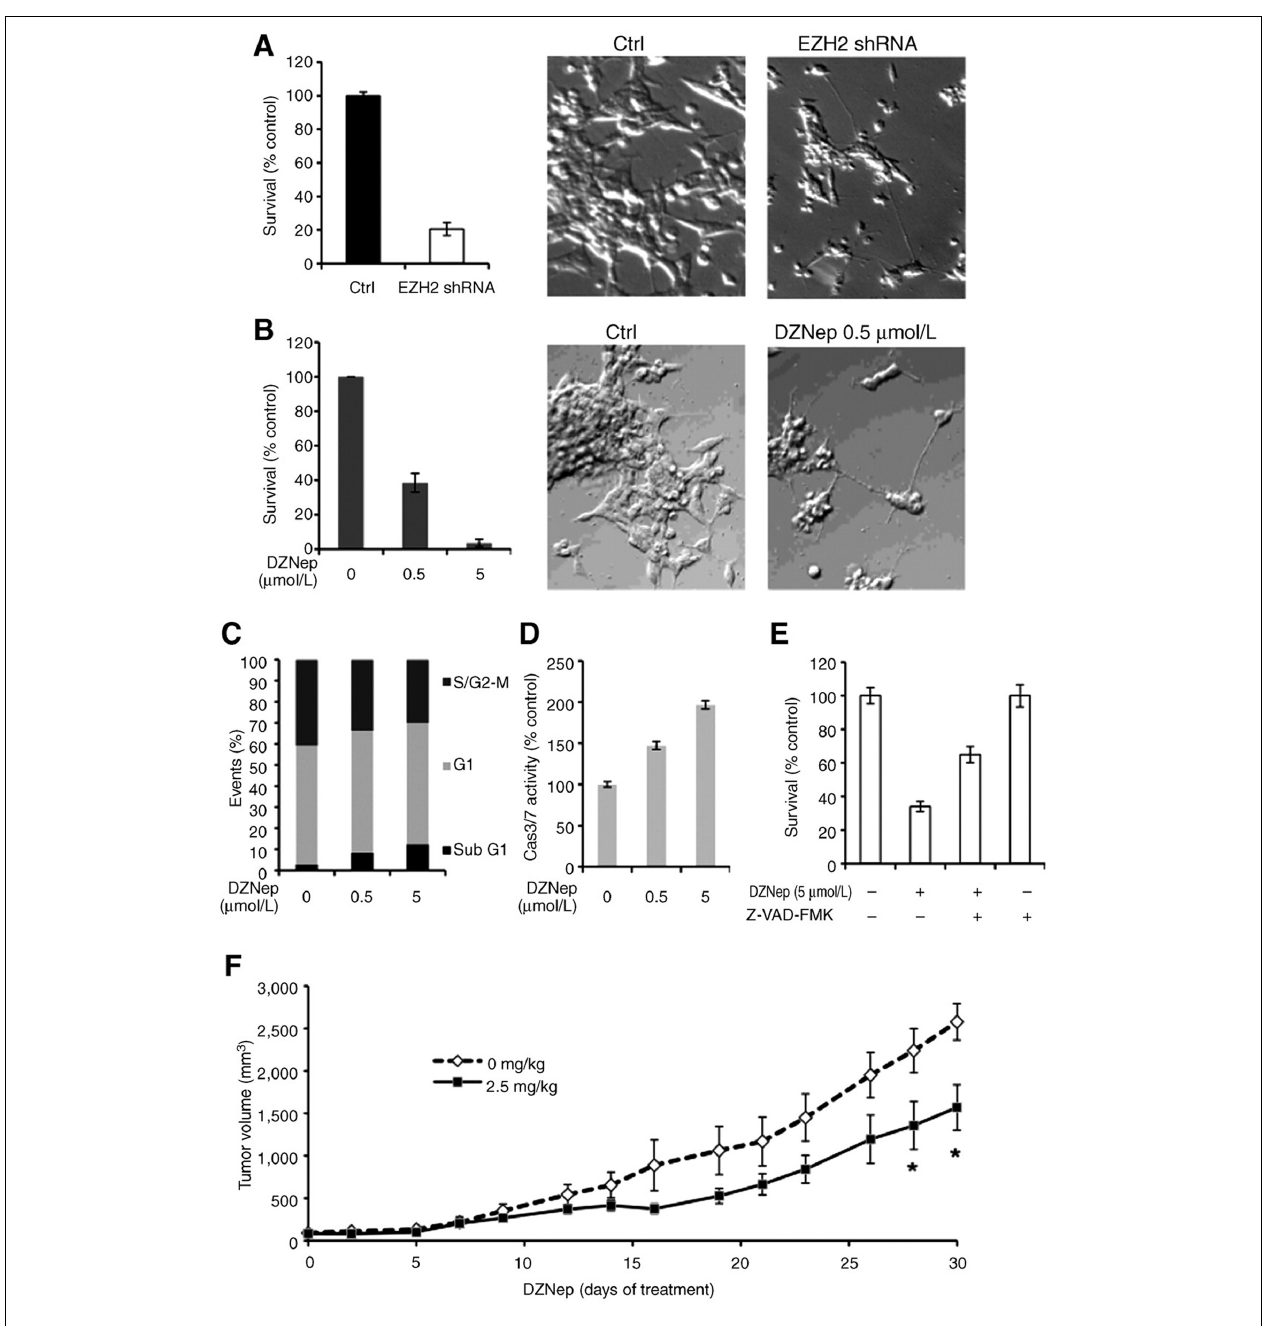
FIGURE 4 | Decrease of EZH2 affects NB cell growth and induces the neurites (Wang etal., 2012). (A) Cell survival in KCNR cells after a 3-day infection with EZH2 or non-target shRNA lentivirus was assessed using a Cell-Titer Blue assay (left).The percentage of surviving cells was normalized by the absorbance value of the non-target shRNA-infected cells (control). Representative images ( × 200) of the non-target shRNA-infected cells (ctrl, middle), EZH2 shRNA–infected cells (EZH2 shRNA, right). (B) KCNR cells were treated with different concentration of DZNep for 96 h. MTS assay was used to detected cell survival (left).The percentage of surviving cells was normalized by the absorbance value of the non-treated cells. Representative images ( × 200) of the non-treated cells (ctrl, middle) and 0.5 μ mol/L DZNep-treated cells (DZNep 0.5 μ mol/L, right). (C) KCNR cells were treated with different concentration of DZNep for 96 h.The cells were stained with